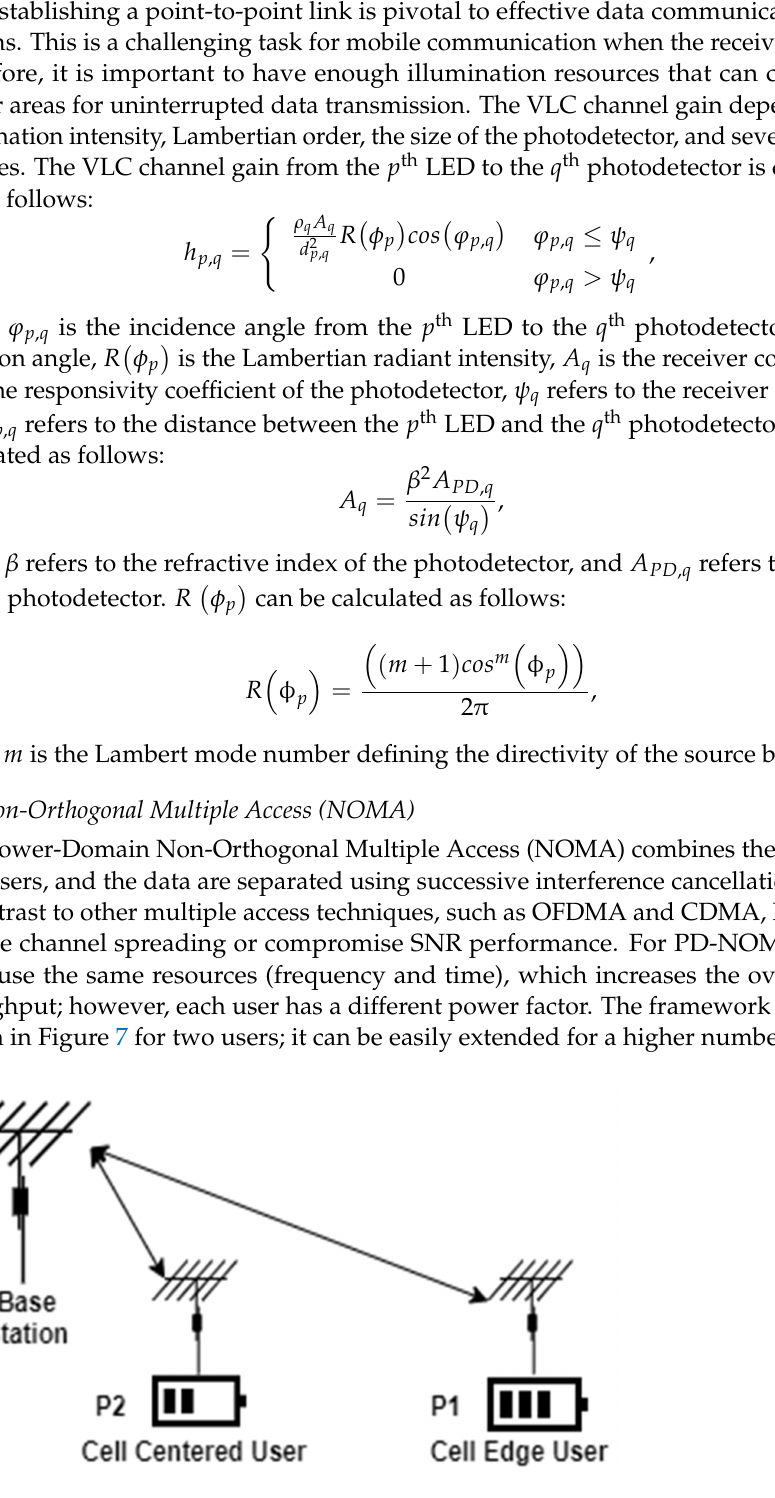
Figure 7. Framework of